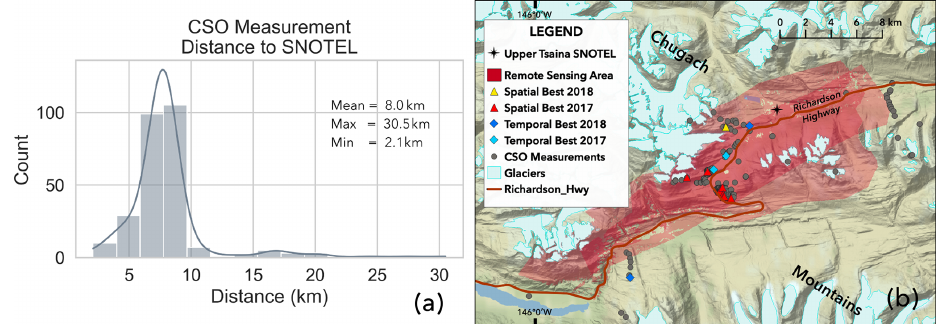
Figure 10. Assimilated measurements. (a) A histogram showing the distance between the CSO measurements available for assimilation and the Upper Tsaina SNOTEL station, subset by the assimilation time period, on or after 15 April ( n = 266). A kernel density estimator is used to smooth the distribution. (b) A map of the CSO measurement locations that includes the best spatial and temporal CSO simulations for both water years. The map is magnified on the area of the highest density of CSO measurements.